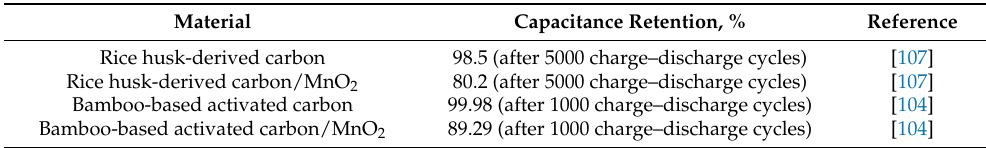
Table 6. Cycling stability of activated carbon and AC-MnO 2